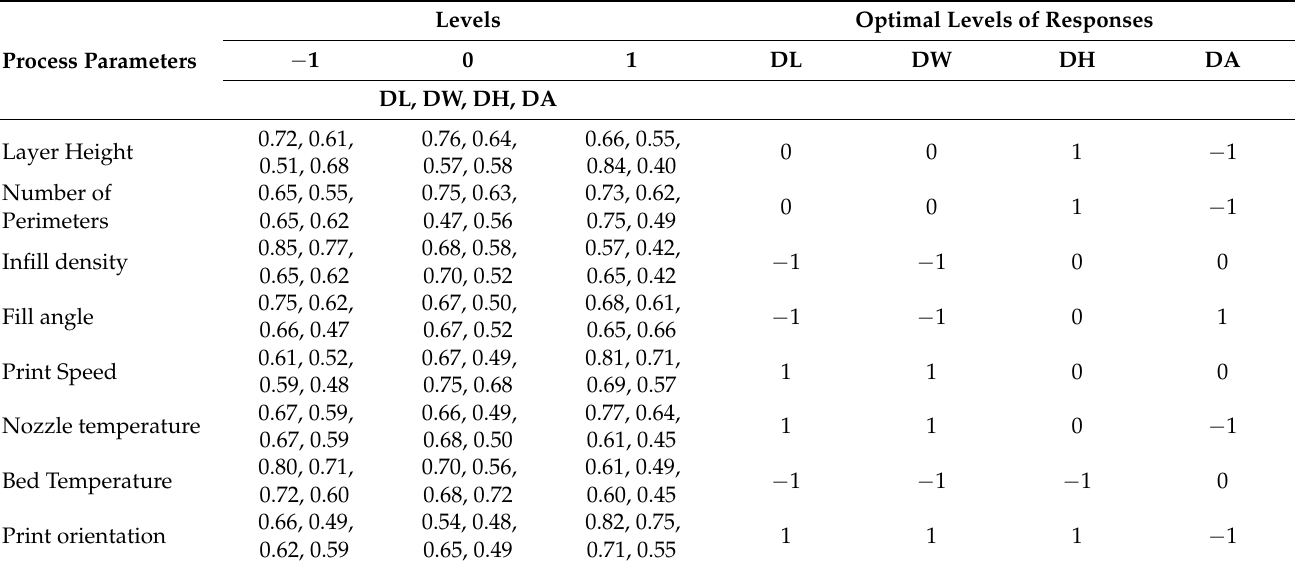
Table 4. Optimal levels for individual